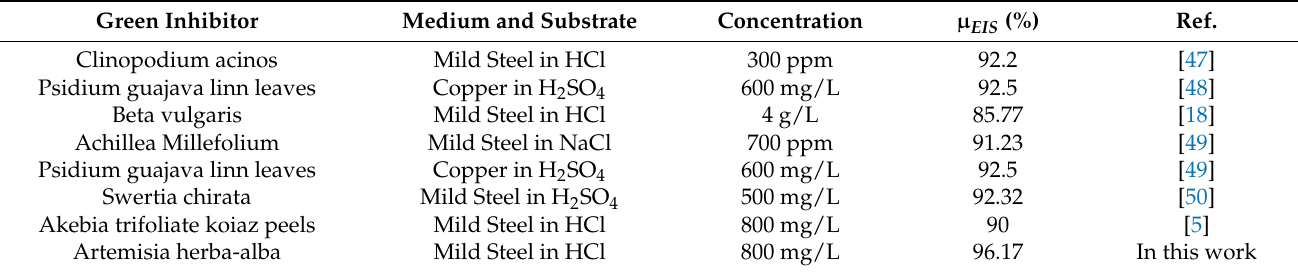
Table 4. Comparison of CHA inhibition efficiencies with other